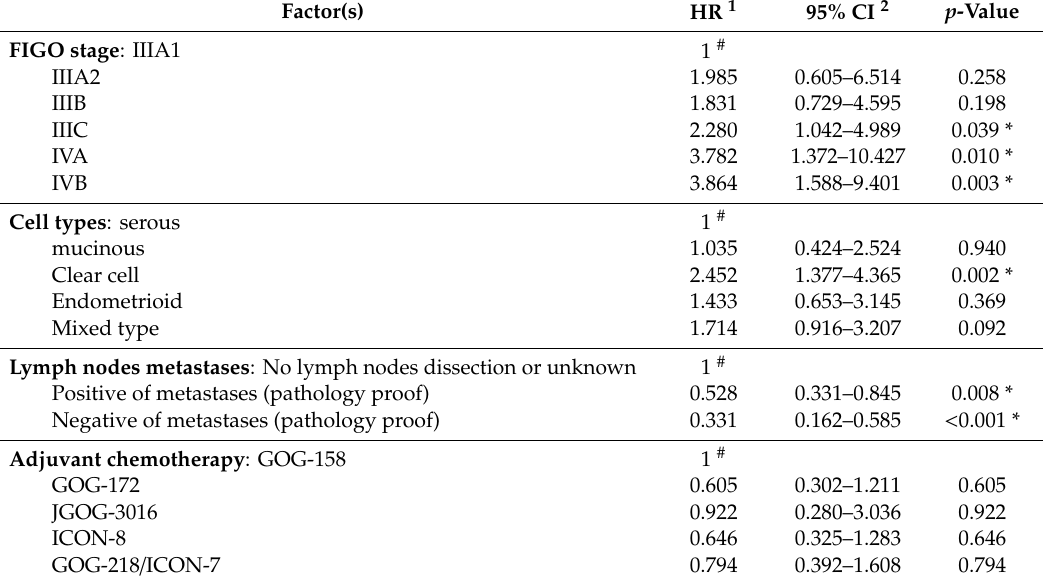
Table 6. Cox regression hazard model for recurrence / persistence risk in all enrolled cases.